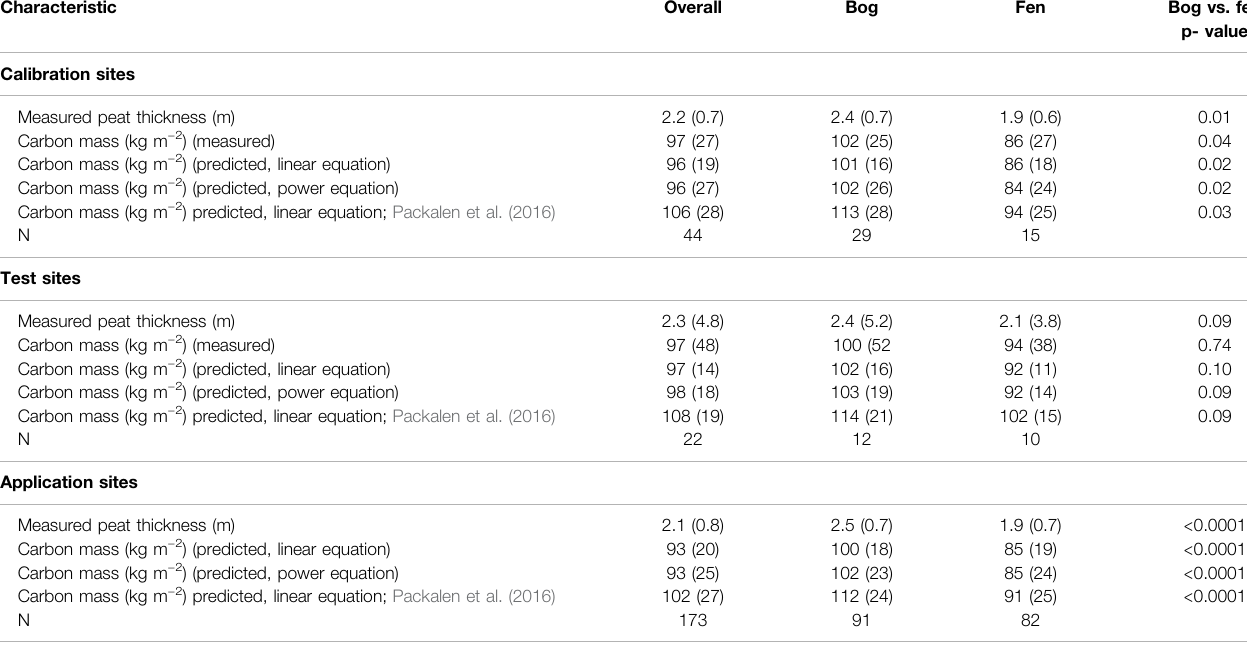
TABLE 2 | Mean ( ± standard deviation) peat depth and carbon mass for 45 calibration, 22 test, and 117 application sites sampled in the 74,300 km 2 study area in the southern Hudson Bay Lowlands, Canada. Characteristic